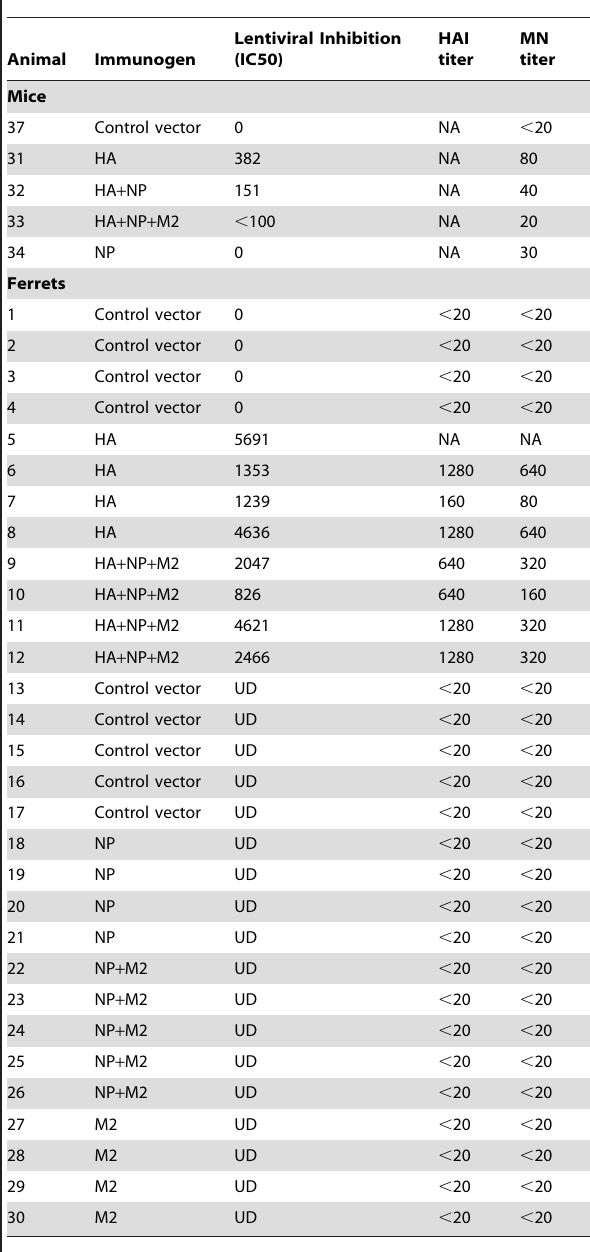
Table 1. Neutralizing Antibody Responses of HA-Vaccinated Mice and Ferrets.